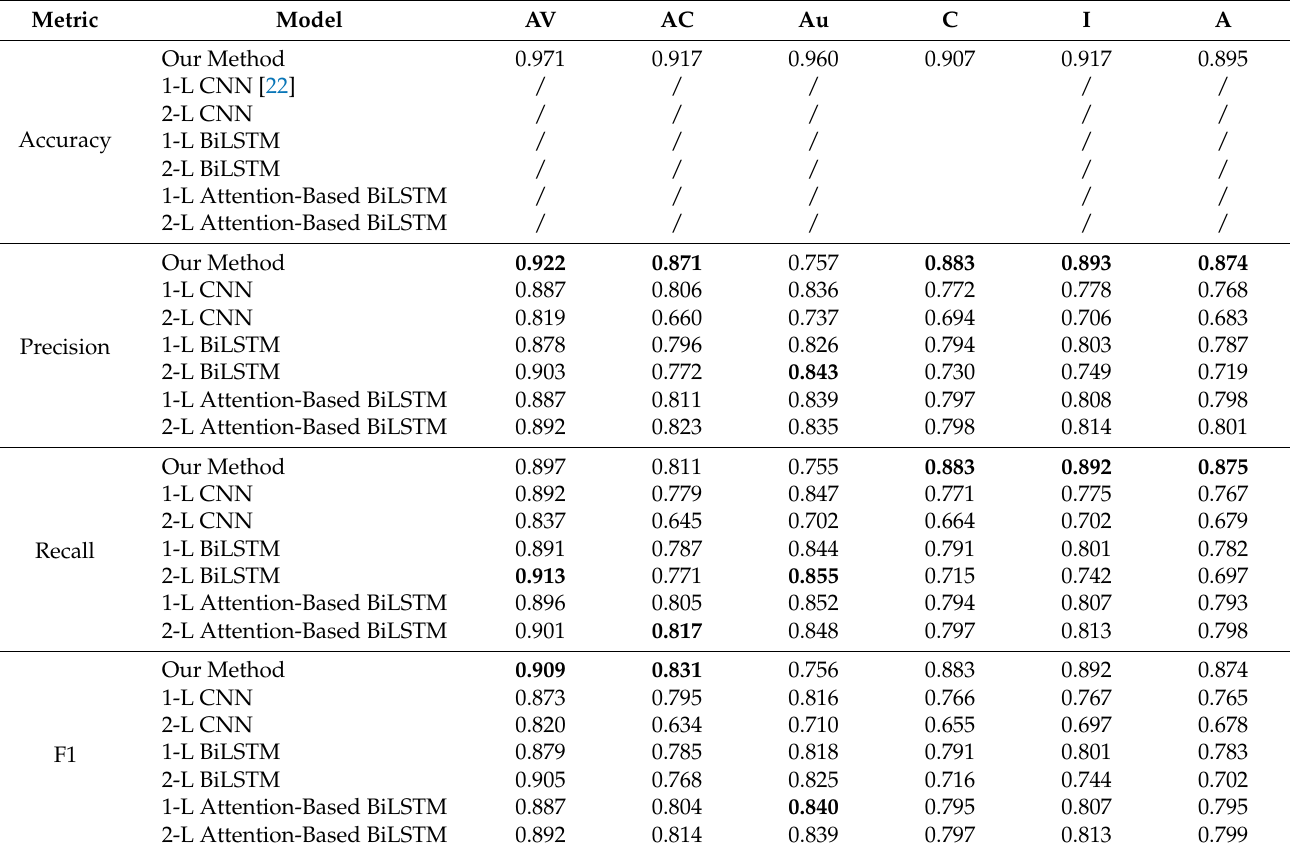
Table 9. Comparison of related methods on the CVSS v2